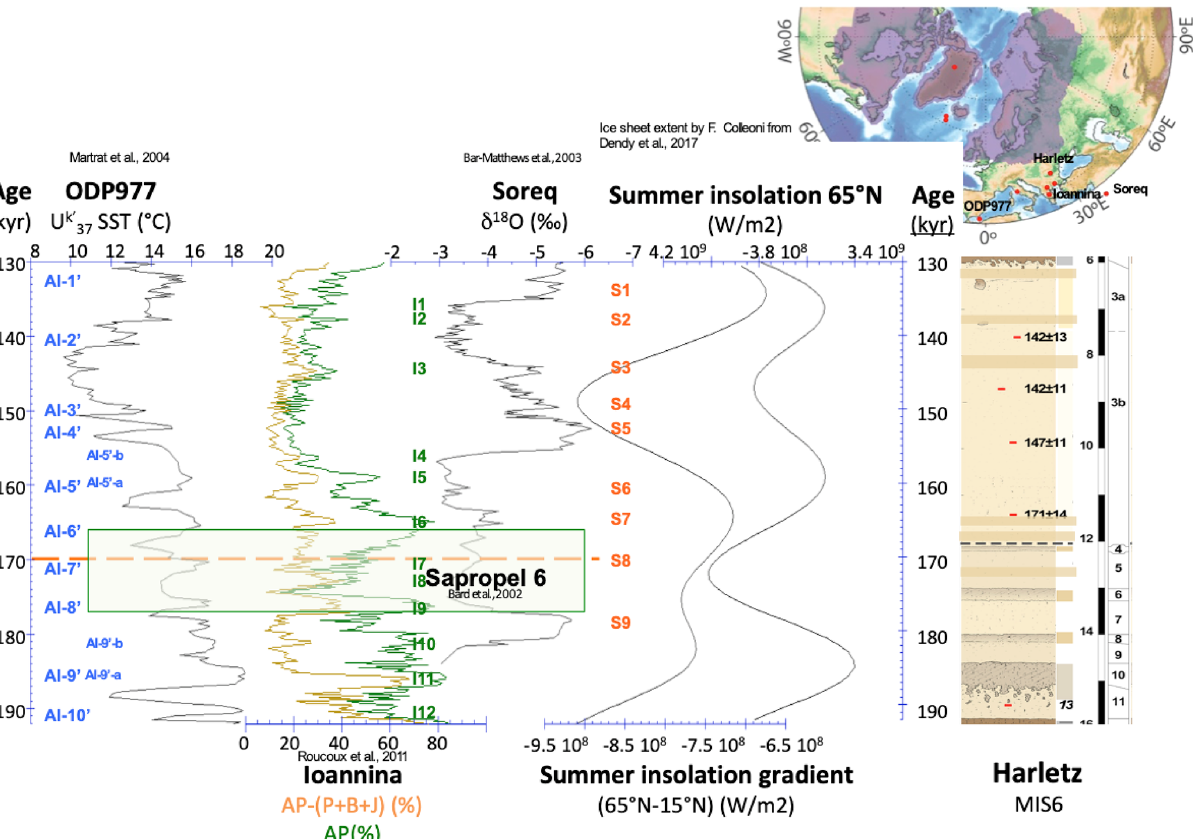
Figure 3. Western (ODP 977 SST – alkenone; Martrat et al., 2004a, b) to eastern (Soreq speleothem δ 18 O; Bar-Matthews et al., 2003a, b) Mediterranean records of MIS 6, including a pollen record from Ioannina I-284 (AP, AP − pine + birch + juniper; Roucoux et al., 2011), compared with summer insolation with an indication of the time occurrence of Sapropel 6 (Bard et al., 2002). The pedostratigraphy of the Harletz MIS 6 record is added with the newly described paleosols and pedogenic horizons for comparison. Labels of the interstadials are as identified in the Alboran Sea. Complementary labels assign warm events to the ODP 977 (AI-5’a, b, AI-9’a, b), Ioannina (I1–12), and Soreq (S1–9) Mediterranean MIS 6 records used in Table 1. MIS 6 ice sheet extent by Florence Colleoni in Dendy et al. (2017).